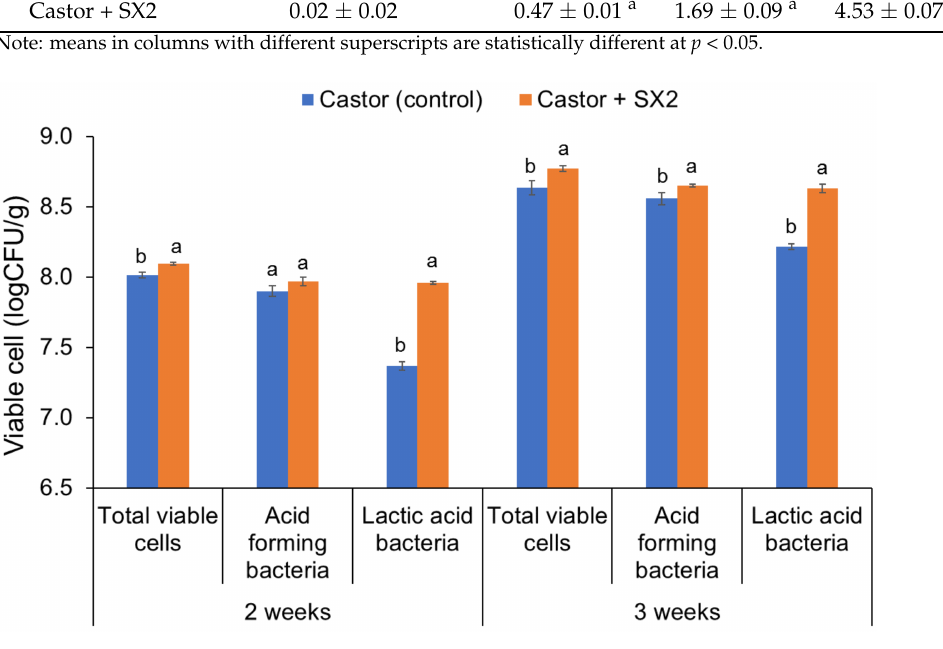
Figure 5. Total viable cells, acid-forming cells, and lactic acid-forming cells of probiotic-supplemented Eri silkworm midgut. Different small letters indicate significant differences in the viable cell (logCFU/g) in midgut between Eri silkworm reared with castor leaves and E. hirae SX2 treated castor ( p <